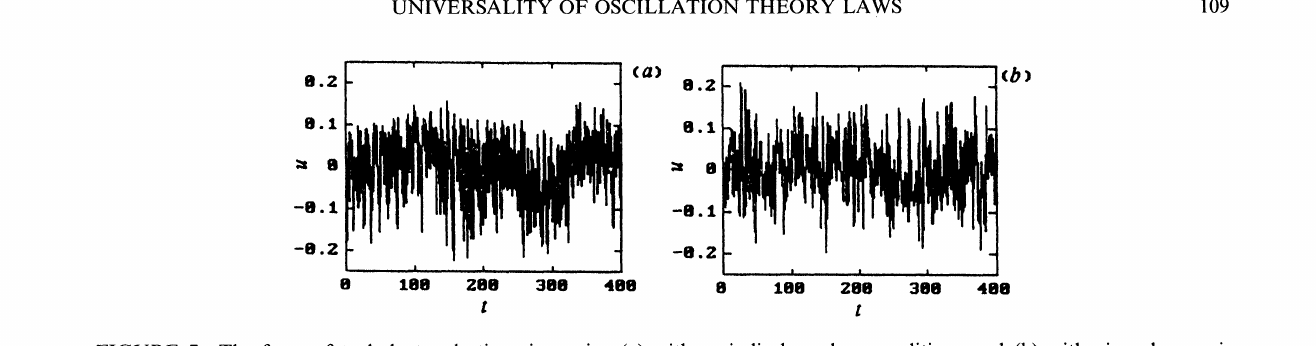
FIGURE 7 The form of turbulent pulsations in a pipe (a) with periodic boundary conditions and (b) with given harmonic disturbance at its inlet.